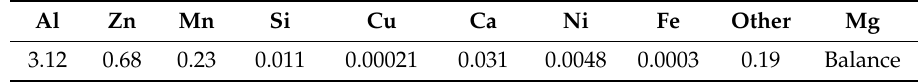
Table 1. Composition of AZ31B magnesium alloy (wt. %).